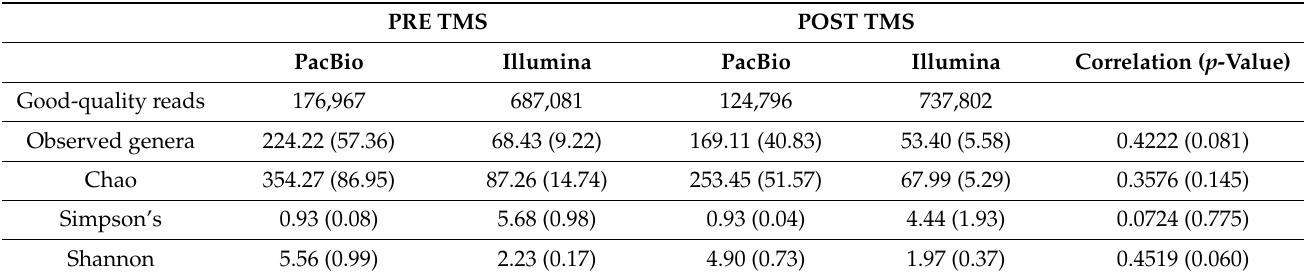
Table 1. Average and standard deviations (SD) of alpha diversity indices, total number of good-quality reads obtained, and correlation and p values comparing results of two different sequencing technologies (PacBio and Illumina) before and after treatment with oral TMS in horses.